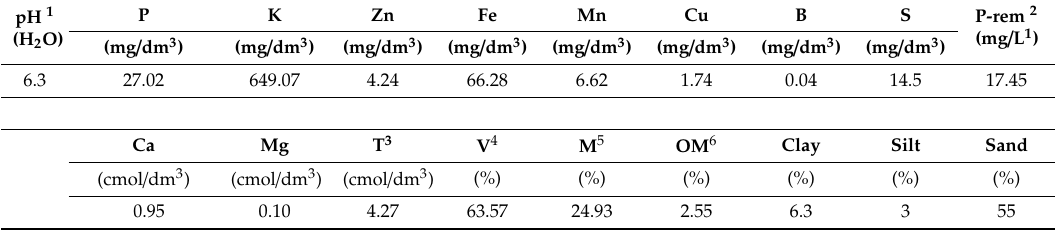
Table 1. Chemical content of the substrate before applying the